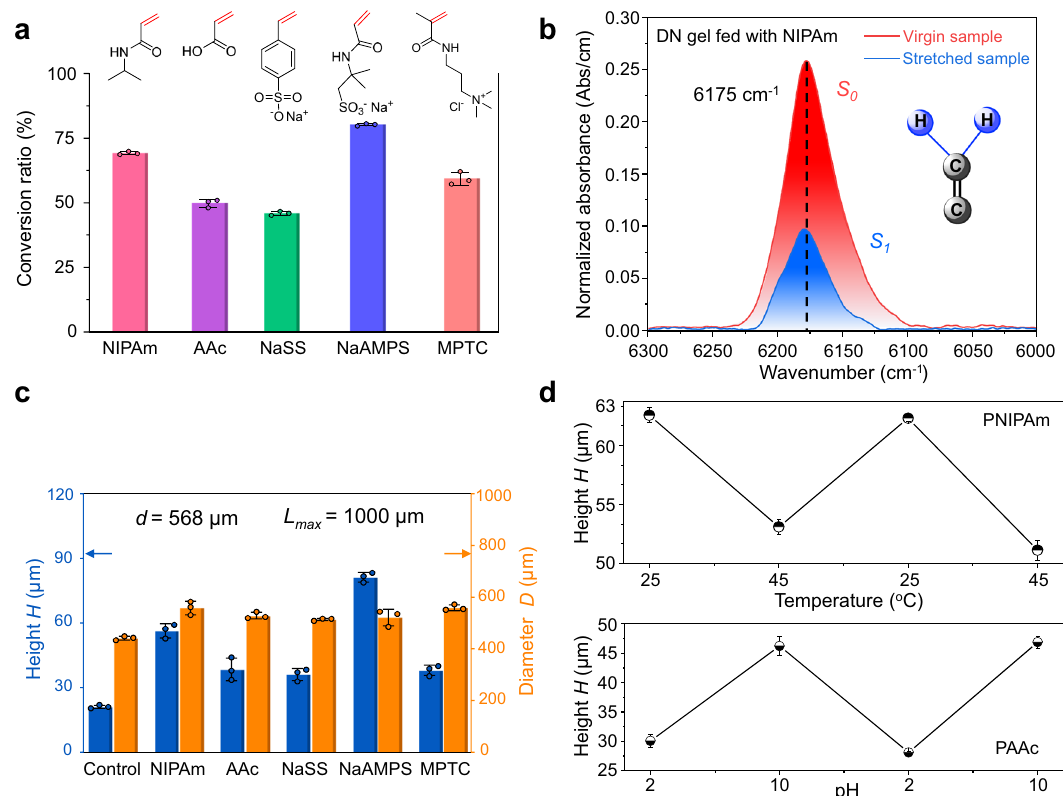
Fig. 3 | Force-triggered microstructure growth of various polymers. a Conversionratioofdifferentfunctionalunsaturatedmonomersinthemechanical force-triggered radical polymerisation, which was characterised in tensile speci- mens fed with different monomers and then stretched. The insets in a show the molecular structures of functional unsaturated monomers used for micro- structures growth. b Transmission near infrared spectra of DN hydrogel fed with 1.0M NIPAm monomer before and after uniaxial stretching to a strain ε =3 (over yielding). The conversion ratio η of monomers in a was calculated from peak area before ( S 0 ) and after ( S 1 ) stretching using η =(1 − S 1 /S 0 )×100%. Inset, cartoon